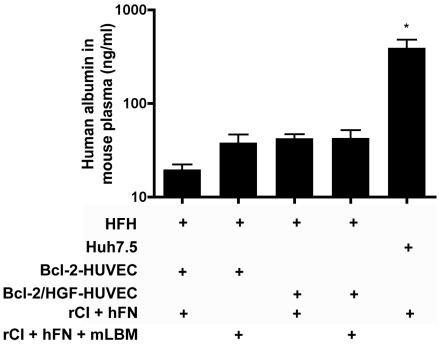
Quantitation of human albumin in the plasma of engrafted mice.Human albumin (20 ng/ml) was detected in the plasma of mice co-engrafted 2 weeks earlier with HFH and Bcl-2-HUVEC suspended in rat tail collagen I (rCI) and human fibronectin (hFN) (left bar). The albumin concentration increased to 40 ng/ml when gels also contained murine liver-like basement membrane (mLBM) proteins or HGF-transduced HUVEC, however no further increases in albumin secretion were observed by using a combination of mLBM plus HGF-HUVEC (middle bars). Highest levels of albumin (average of 392 ng/ml) were observed in mice harboring Huh-7.5/Bcl-2-HUVEC gels (right bar). Data is expressed as ng/ml human albumin in mouse plasma +/− S.E.M.